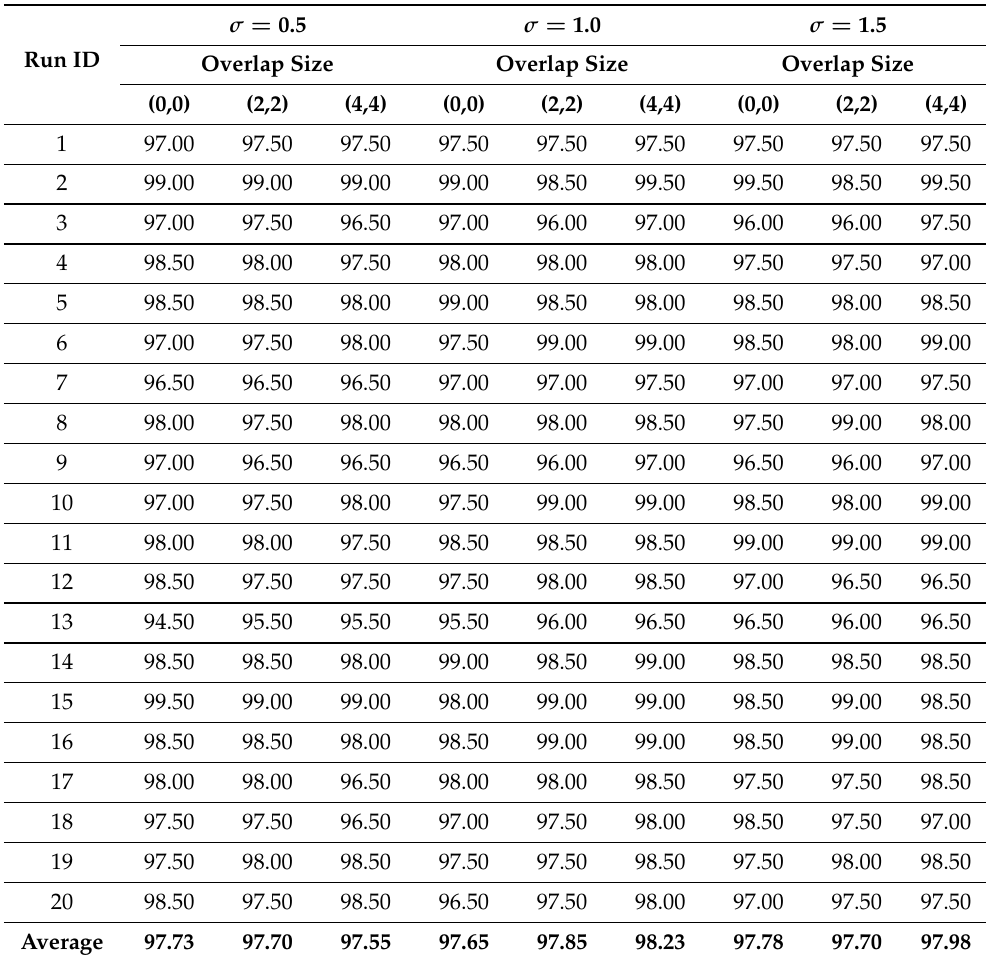
Table A2. The results of the runs for Gaussian noise with standard deviation of 0.01 using different values of σ .